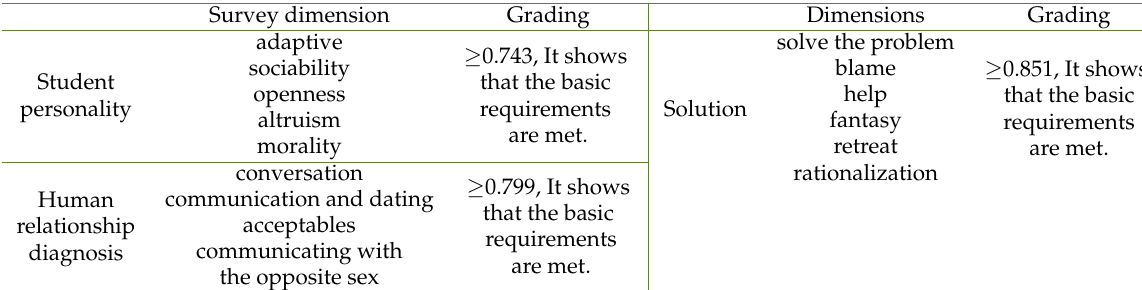
Table 2. Details of the investigators’ composition of the questionnaire.